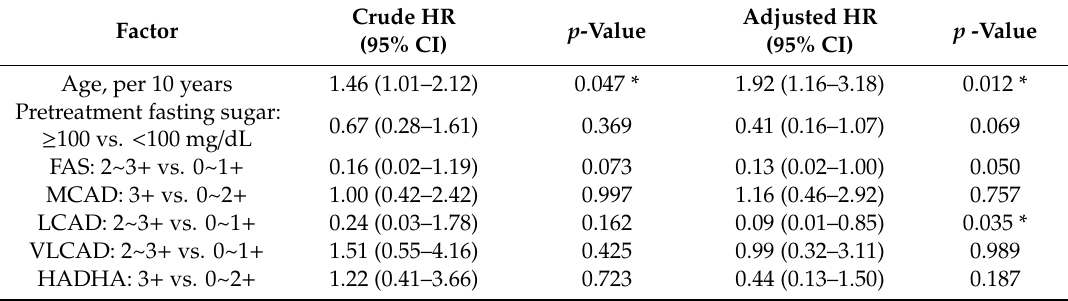
Table 7. Crude and adjusted HRs with 95% CIs for mortality related to clinical parameters and fatty acid oxidation-related expression of enzymes. T3 / T4 case ( n =